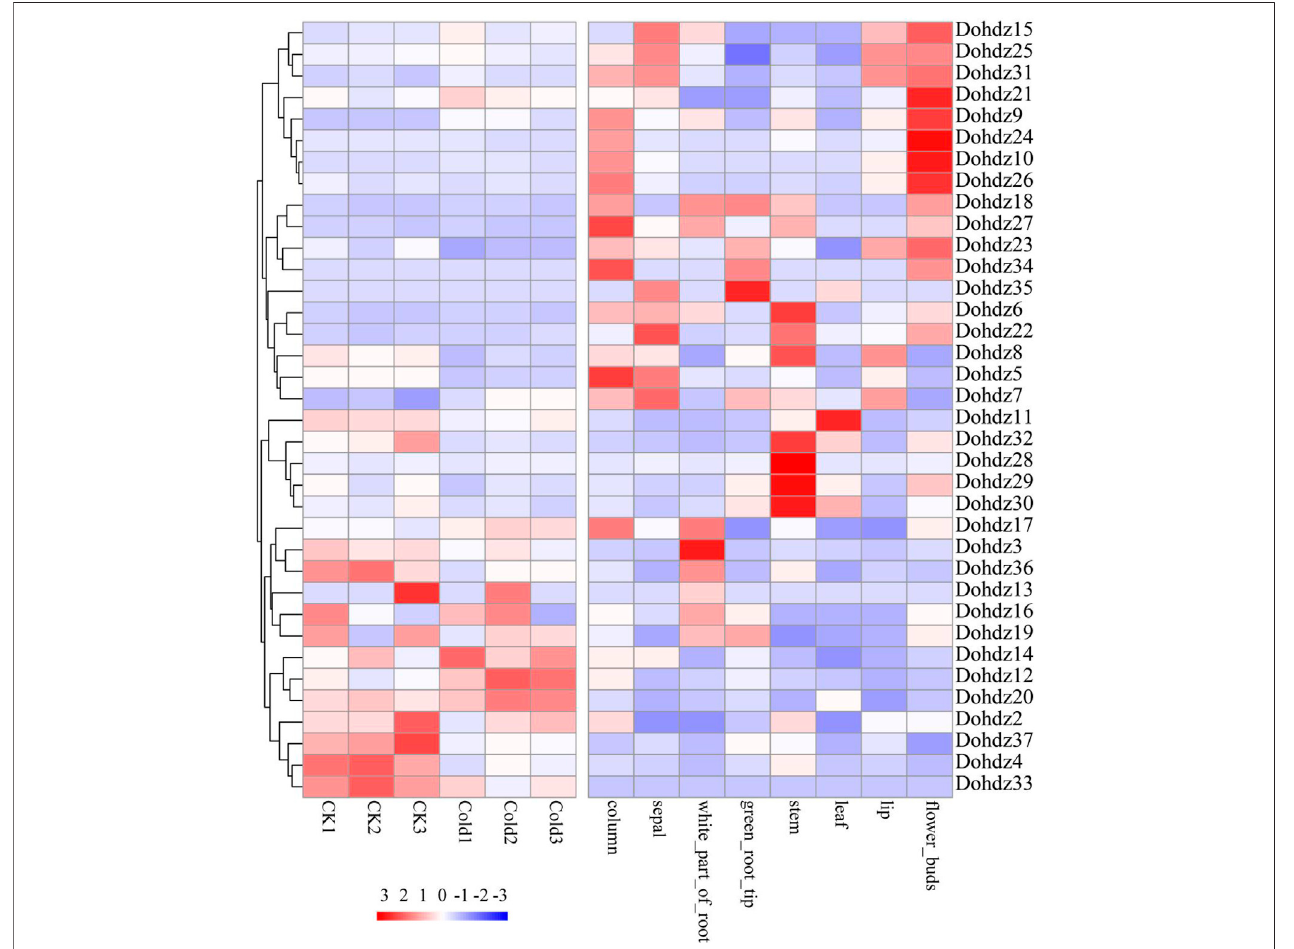
FIGURE 4 | Expression patterns of these 37 HD-ZIP genes in different tissues and under cold